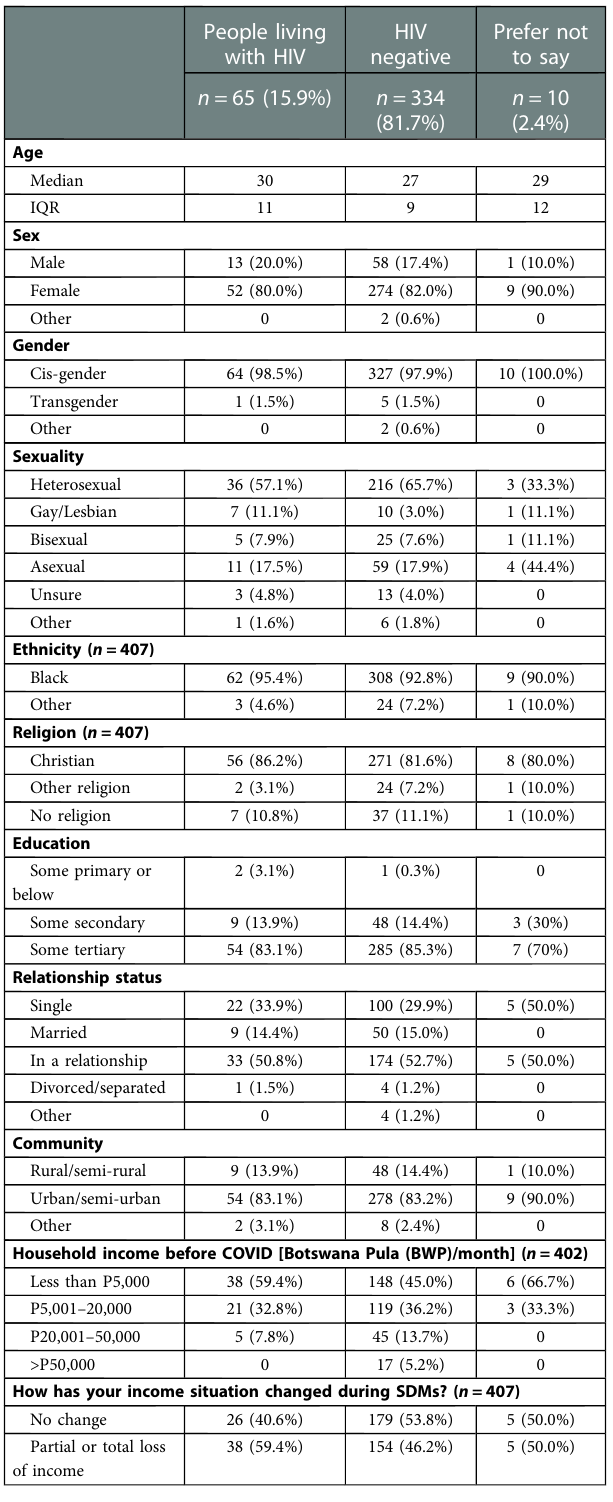
TABLE 1 Demographic characteristics of participants of the 2021 Botswana I-SHARE study, an online cross-sectional survey. People living with